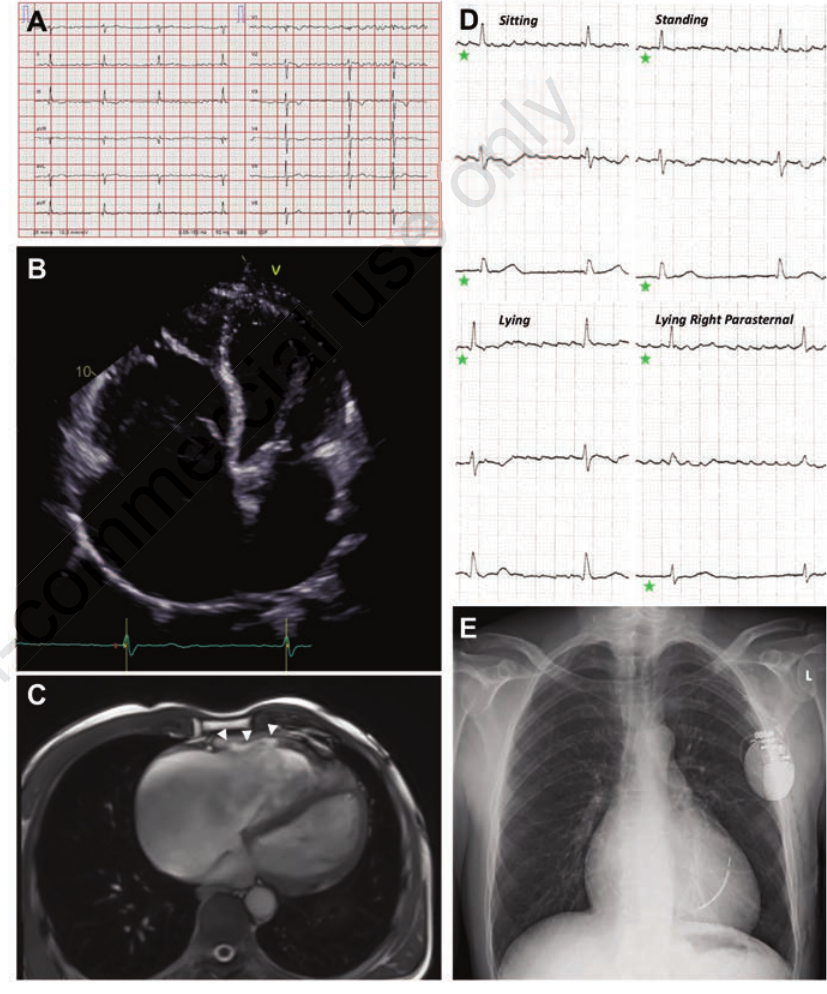
Figure 1. Phenotypical findings in this patient with AC. A) ECG changes typical for right- dominant AC include negative T-waves in V1 to V4 as well as flattened T waves in the limb leads. The patient presented in atrial fibrillation. B) Transthoracic echocardiography demonstrated a severely dilated RV with wall motion abnormalities, along with severe dilation of the right atrium. Systolic function was reduced in both ventricles. C) MRI found late gadolinium enhancement (arrowheads) in the basal portion of the RV free wall. D) Manual screening for S-ICD implantation, including for a right parasternal posi- tion of the device, revealed at least one possible detection vector (green arrows) when the patient was lying, sitting or standing. E) Chest X-ray (a.p.) of the final position of the implanted transvenous device illustrates the position of the single-coil ICD electrode high in the right ventricular